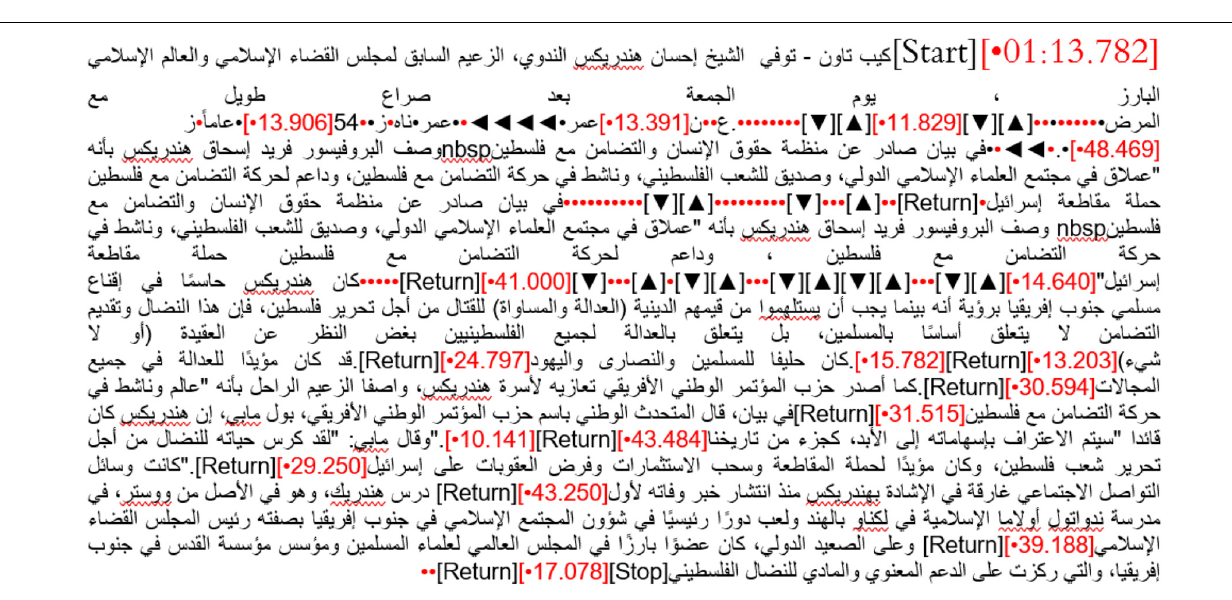
FIGURE 8 | Linear representation of translation for project 3.